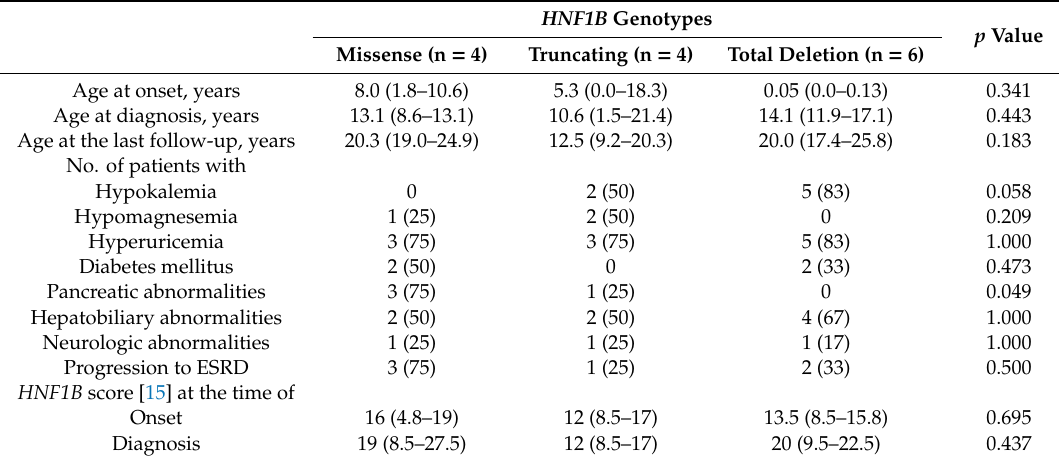
Table 3. Comparison of the phenotypes according to the